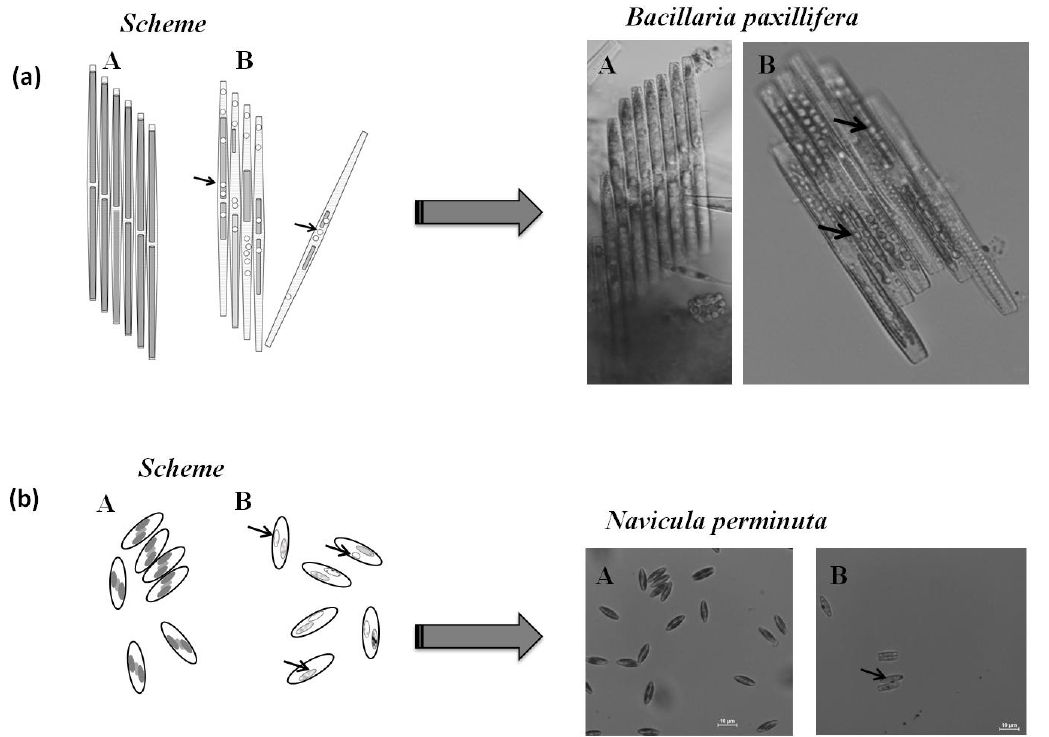
Figure 2. Examples of cells of Bacillaria paxilifera ( a ) and Navicula perminuta ( b ) with normal (A) and abnormal chloroplasts (B). Chloroplasts treated as abnormal have a deformed shape compared to the ones correctly formed. The shape of the chloroplast itself and thus its alternations are species- and/or genus-specific.